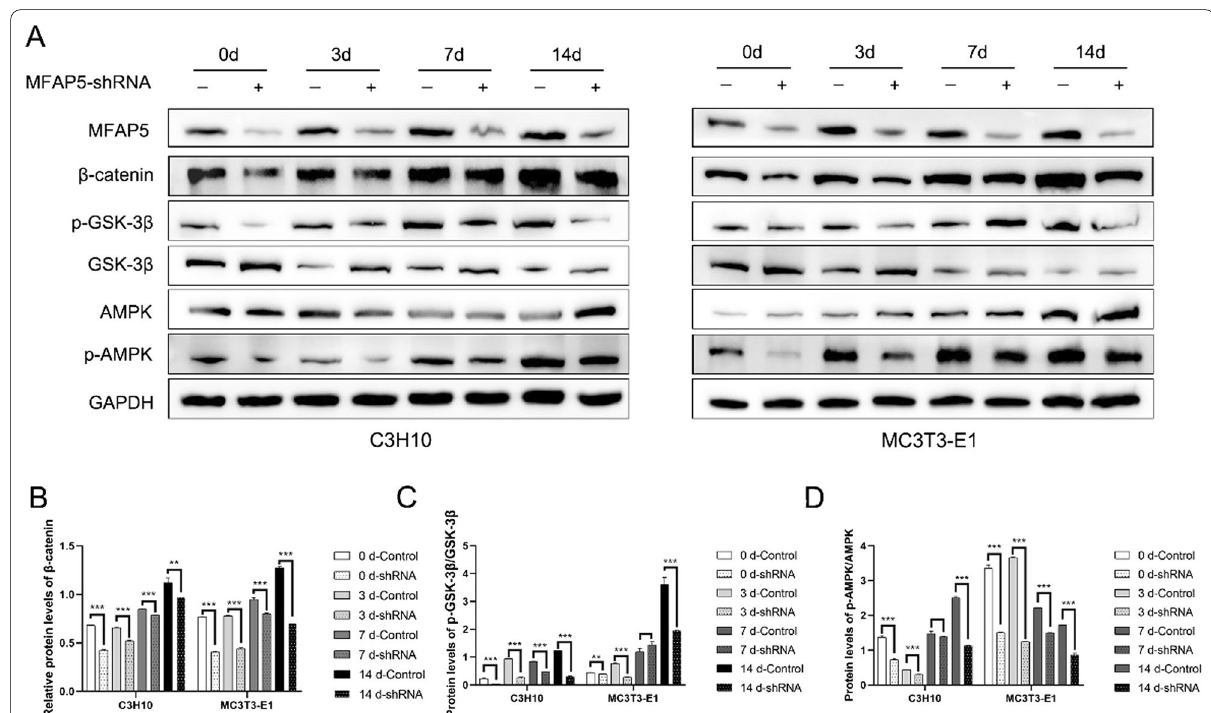
Fig. 3 MFAP5 knockdown inhibited osteogenesis by affecting the Wnt/β-catenin and AMPK signaling pathways. A These pathways were activated in C3H10 and MC3T3-E1 cells during osteogenic induction; the levels of MFAP5, β-catenin, p-GSK-3β, AMPK, and p-AMPK increased, while that of GSK-3β decreased, as osteogenic induction proceeded. Wnt/β-catenin and AMPK signaling were inhibited in shRNA-transformed C3H10 and MC3T3-E1 cells throughout osteogenic differentiation. B – D Relative protein levels of β-catenin, p-GSK-3β/ GSK-3β and